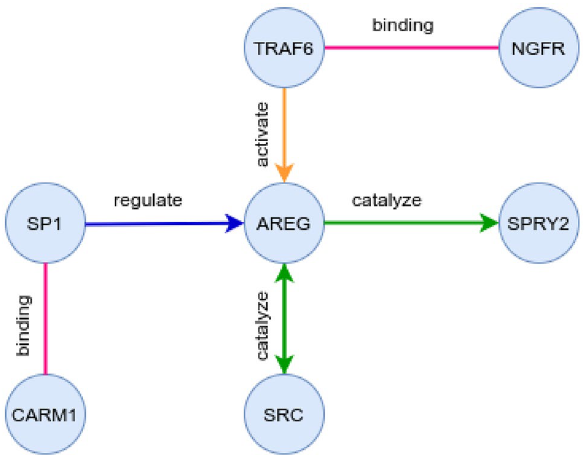
Figure 4. An example of the protein functional interaction network with the various relation types highlighted by different colors.